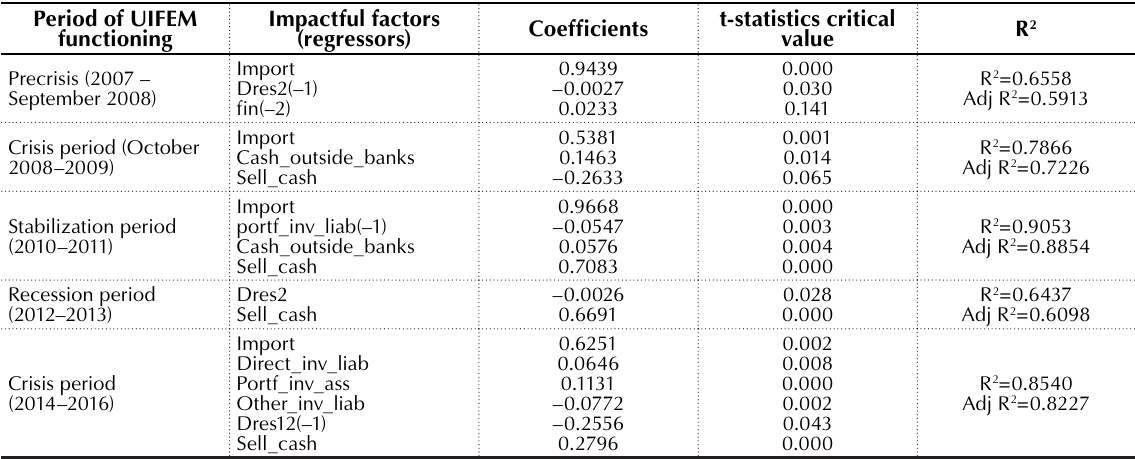
Table 4. The models of the foreign currency exchange demand at the UIFEM (non-cash segment). The foreign currency exchange demand is the dependent variable